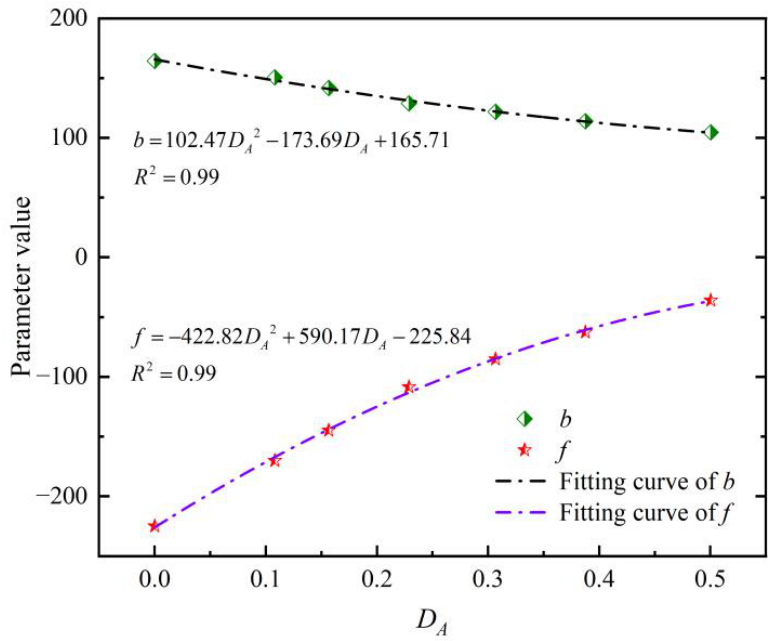
D . Figure 20. Variation of parameter b and f with D A A